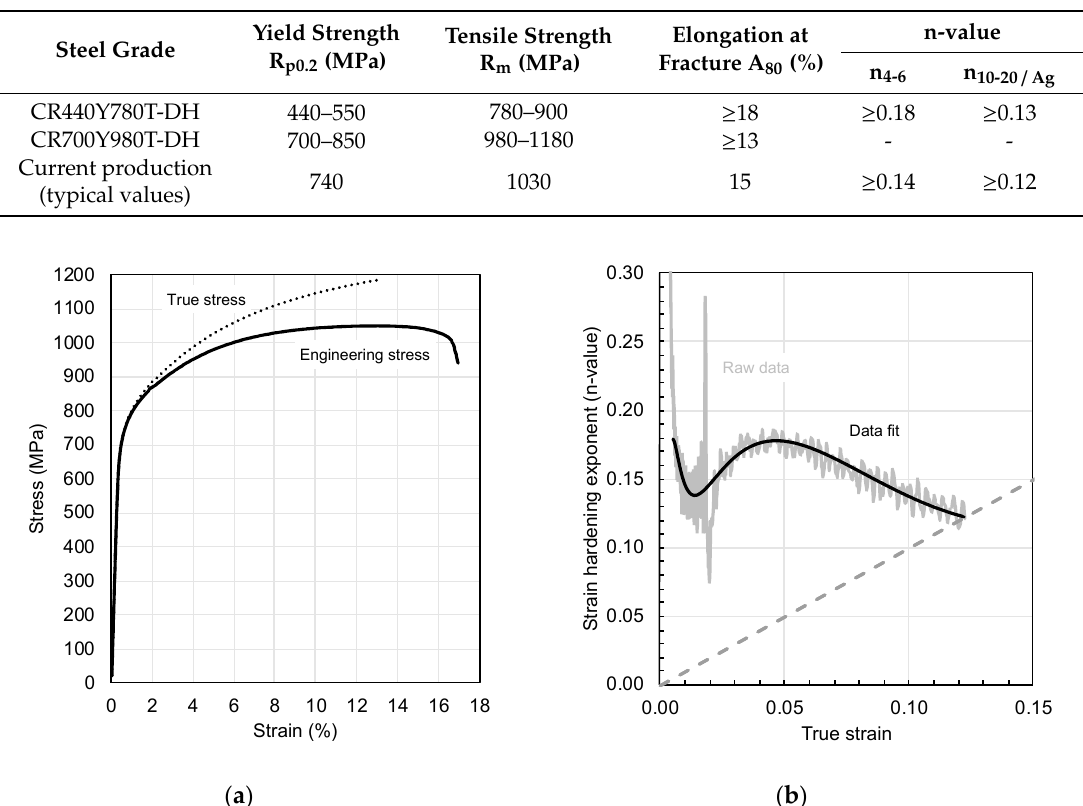
Figure 12. ( a ) Stress-strain curve obtained from uniaxial tensile test; ( b ) evolution of strain hardening exponent in function of true strain (dashed line represents the Considère criterion).